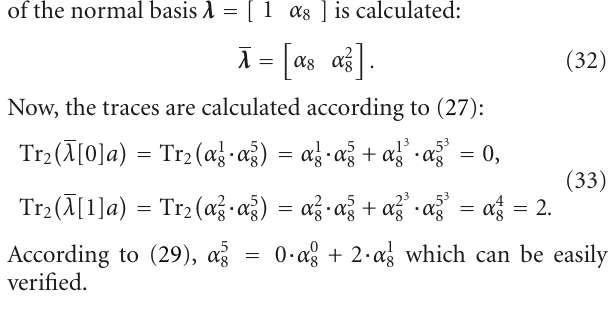
decompose elements of a Galois field along a specified